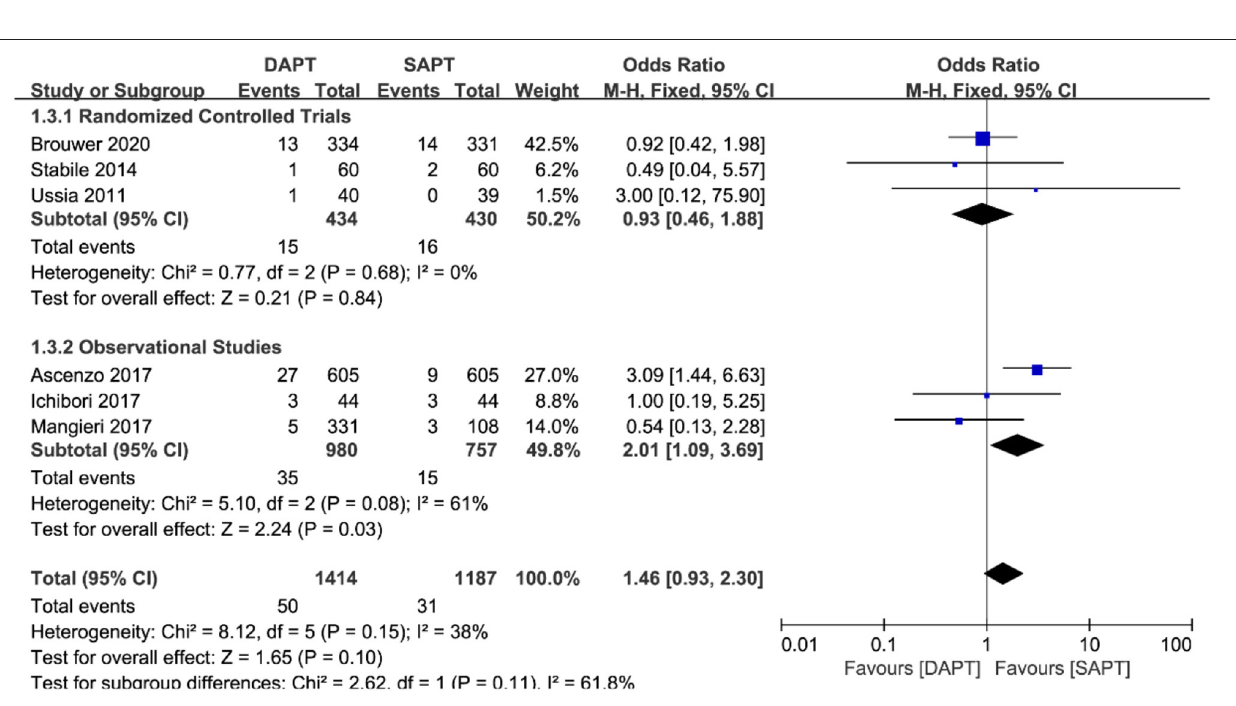
Frontiers in Cardiovascular Medicine |